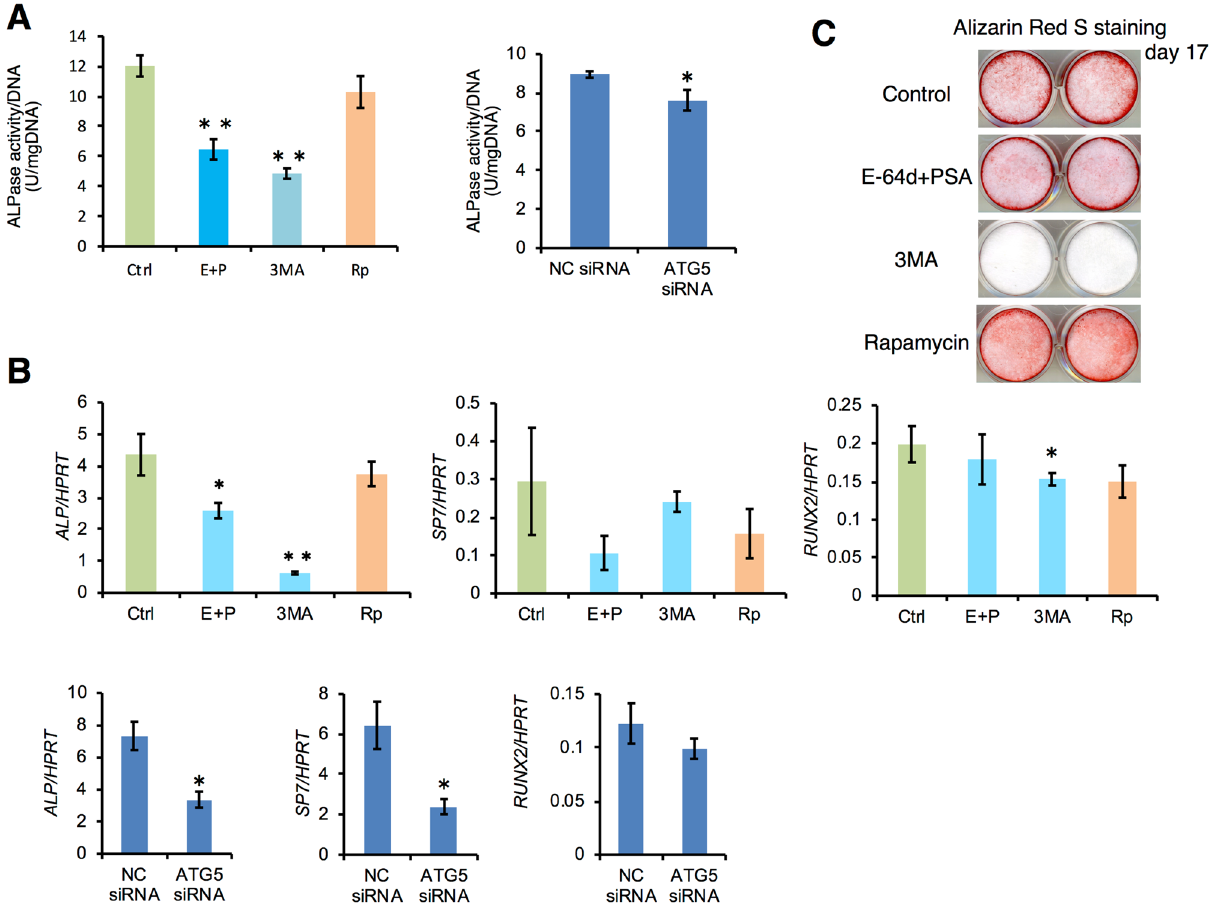
Figure 8. Suppression of autophagy inhibits the ALPase activity in human periodontal ligament (HPDL) cells. ( A ) Quantification of ALPase activity after 6 days of HPDL cell culture in mineralisation-inducing medium in the presence of autophagy inhibitors E-64d plus pepstatin A (10 µg/ml), 3-MA (10 µM), or rapamycin (250 nM), or siATG5 treatment. ALPase activity was determined as described in the Methods section. Activity in units/mg protein for the cell lysates is shown. **p < 0.01 vs control, ctrl: control; E + P: E-64d plus pepstatin A; 3MA: 3-MA; Rp: rapamycin. ( B ) Relative quantification of ALP, SP7, and RUNX2 mRNA expression levels was performed after 6 days of HPDL cell culture in mineralisation-inducing medium in the presence of autophagy inhibitors, E-64d plus pepstatin A (10 µg/ml), 3-MA (10 µM) or rapamycin (250 nM) or si ATG5 treatment. The relative level of collagen type I mRNA in human periodontal ligament (HPDL) cells was quantified by RT-qPCR. Quantitative mRNA values were normalised to the amount of HPRT mRNA. Values are the means ±